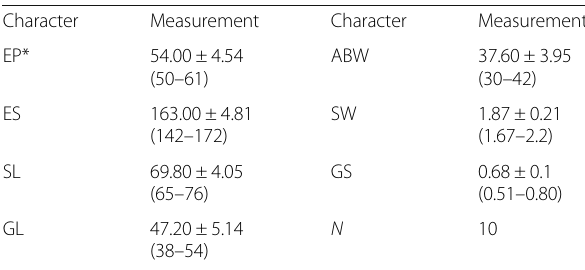
Table 2 Morphometric data of first-generation males of Steinernema carpocapsae IRMoghan1. All measurements are